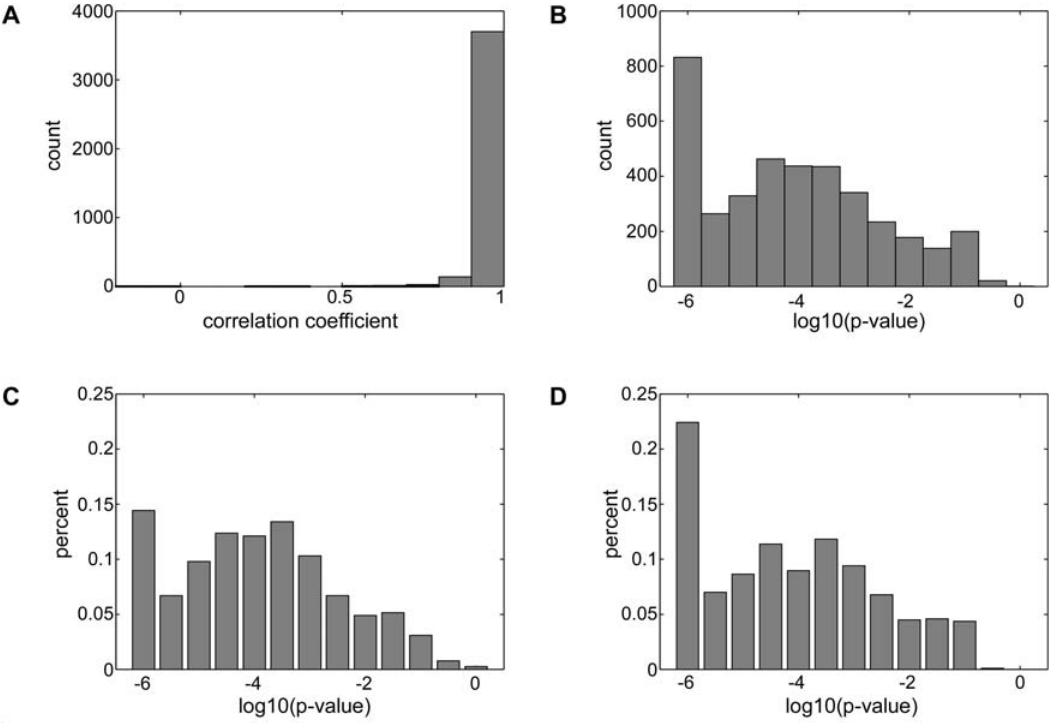
Figure 5. Similarity of expression patterns for overlapping conditions of single-nucleotide substitution variants. Pearson correlation coefficients (A) and corresponding p-values (B) were calculated for the mean expression profiles observed in shared conditions of pairs of motifs from the filtered core dataset that differ by a single nucleotide and share at least one condition where they both display significant expression coherence. (C) p-values for substitutions from C to G and from G to C. (D) p-values for substitutions from A to T and from T to A. Substitutions between C and G tend to produce correlations between mean expression profiles that are less significant than other substitution types. For the purpose of plotting the p-value histograms very small p-values were conservatively set to 1e-06.